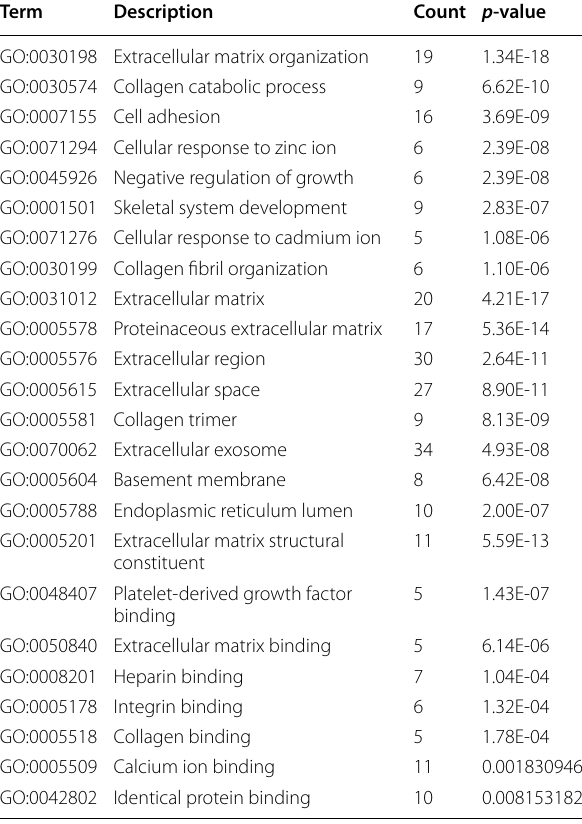
Table 3 GO analysis of DEGs associated with gastric